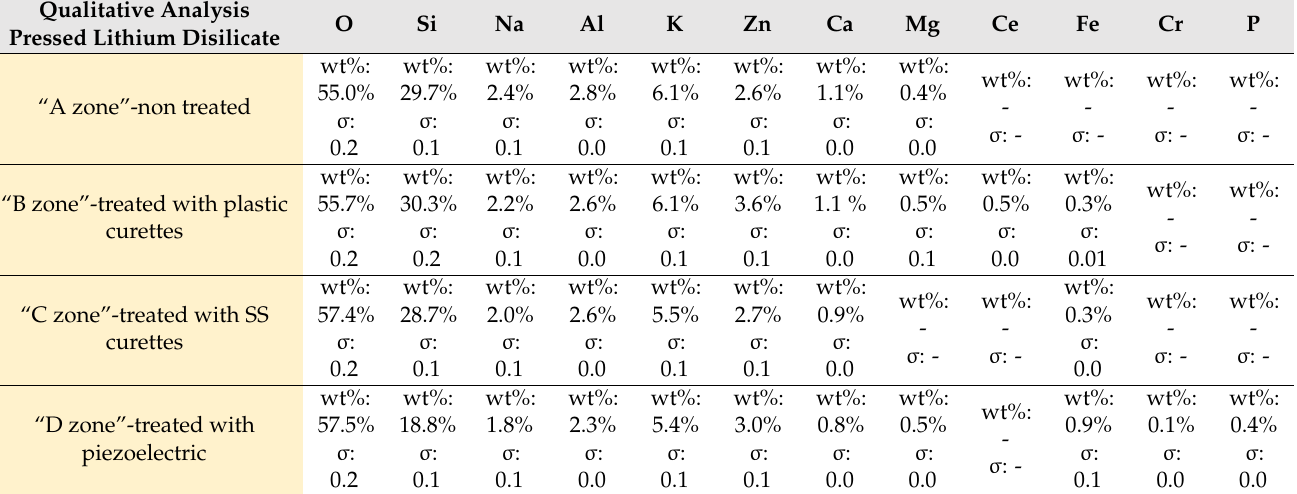
Table 3. CAD-CAM Lithium